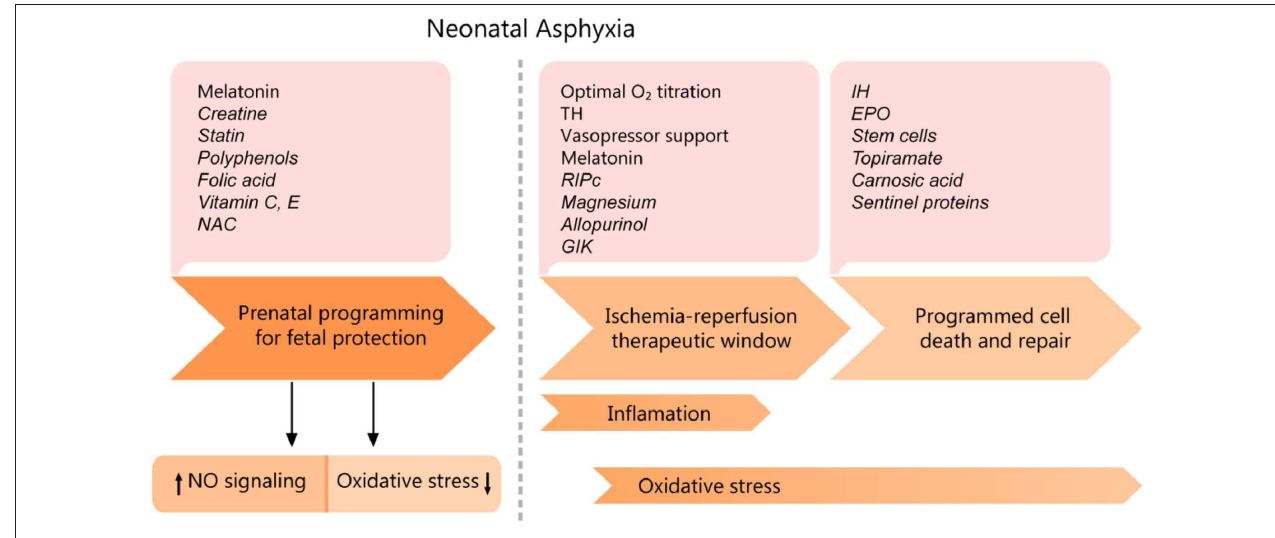
FIGURE 6 | Cardiomyocyte asphyxic injury timeline and potential therapeutic interventions. EPO, erythropoietin; IH, Intermittent ischemia; GIK, glucose- insulin-potassium; NAC, N-Acetyl- cysteine; RIPc, remote ischemic pre/postconditioning; TH, therapeutic hypothermia. Experimental data are shown in italics.